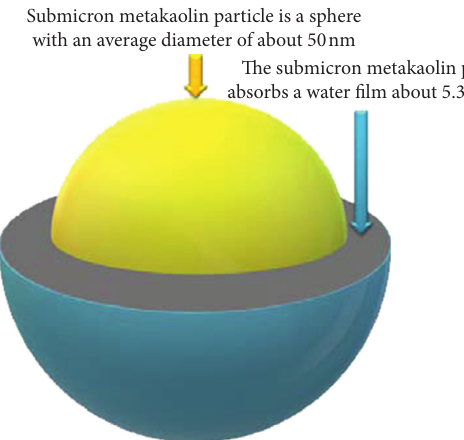
Submicron metakaolin particle is a sphere with an average diameter of about 50nm